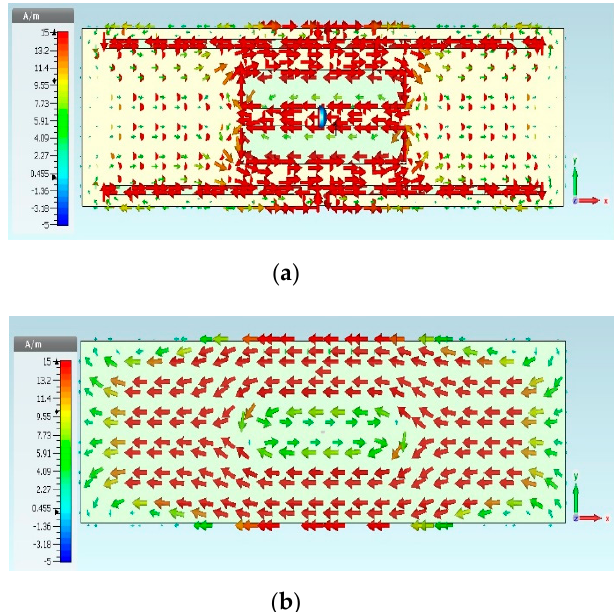
Figure 5. Current distributions of the proposed radio frequency identification (RFID) tag antenna. ( a ) Top surface and ( b ) ground plane.